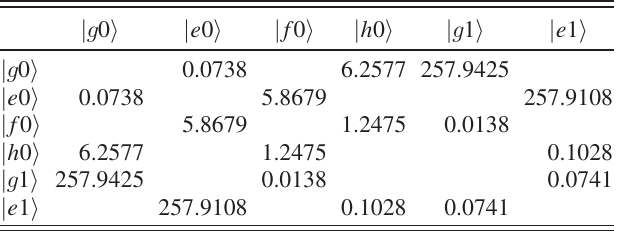
TABLE II. Single-photon matrix elements.